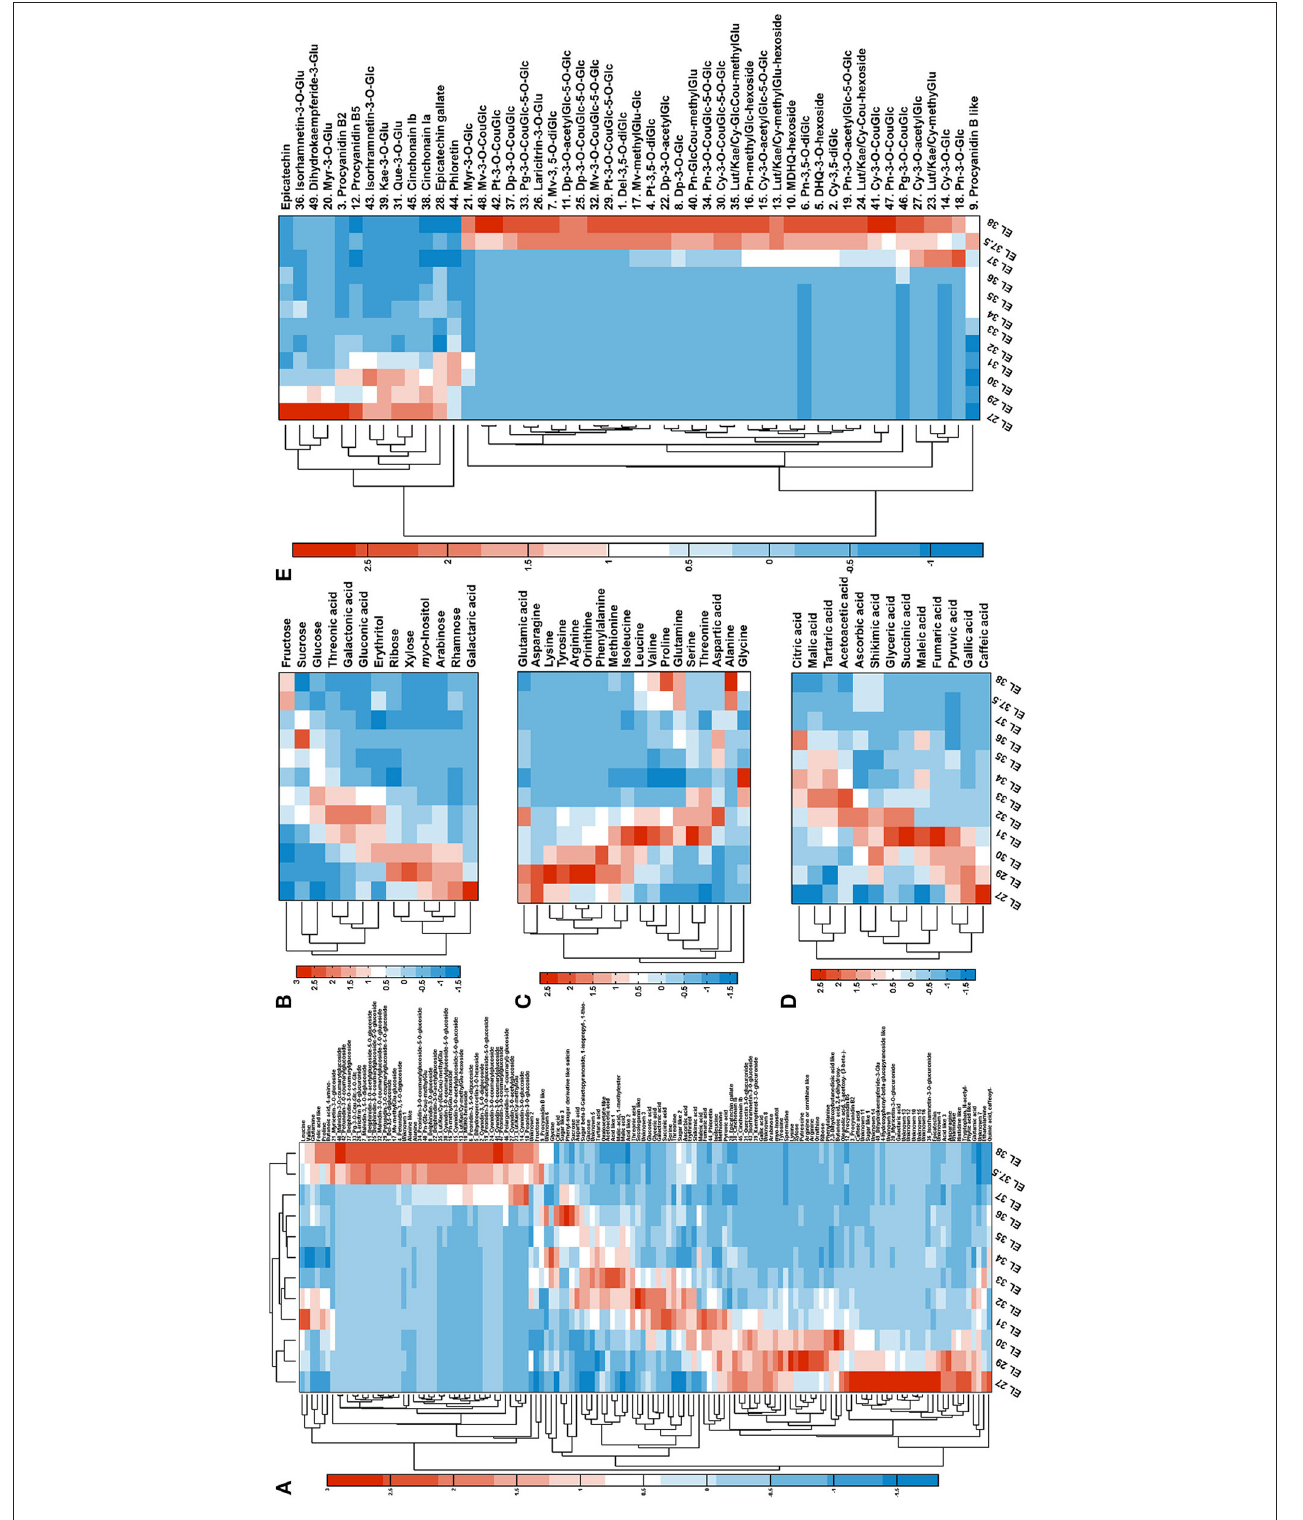
FIGURE 2 | Metabolome dynamics of developing grape berry. (A) Overview of the metabolite dynamics with bi-hierarchical-clustering heat map. (B–D) Present the dynamics of sugars (including sugar alcohol and sugar acids), amino acids and organic acids. (E) Presents the dynamics of flavonoids.